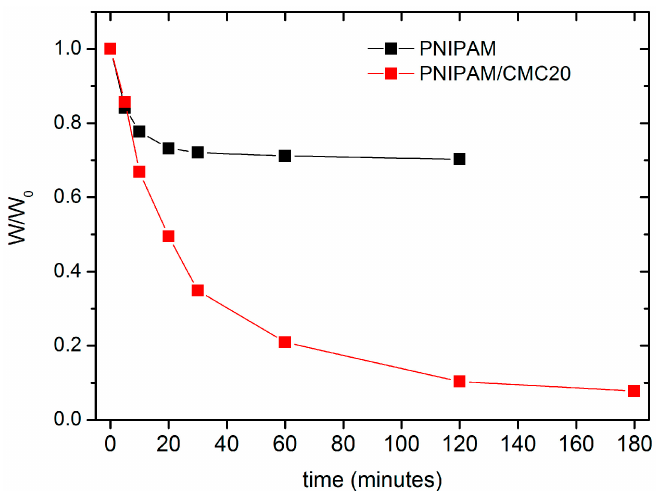
Figure 6. Water retention (defined as the weight W of the hydrogel divided by weight of the hydrogel swollen at 295 K W 0 ) as a function of immersion time in water at 315 K for the pure PNIPAM and the PNIPAM/CMC20 hydrogels.